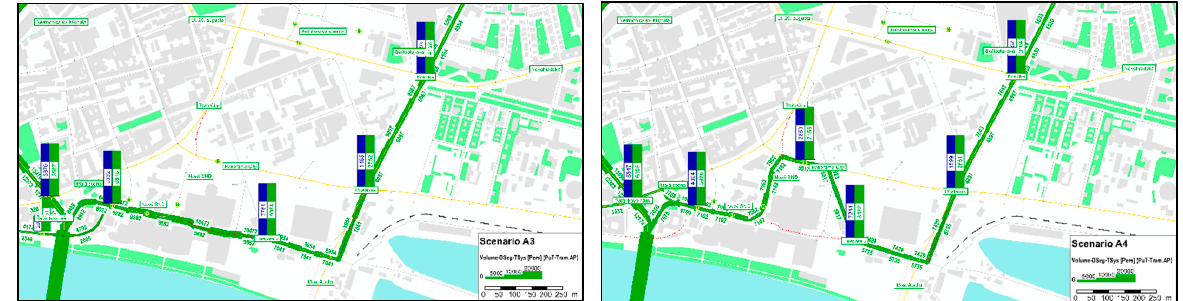
Figure 11. Scenarios of tramway routes with the stops for optimisation of zones.